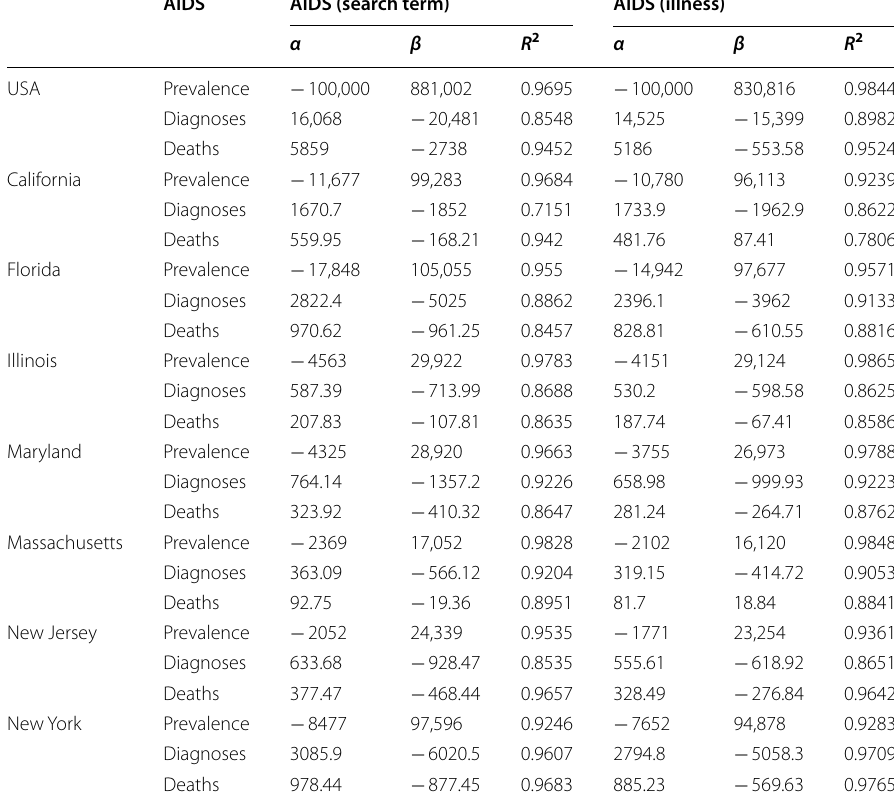
Table 5 Estimated Logarithmic forecasting models for USA and selected states AIDS AIDS (search term)